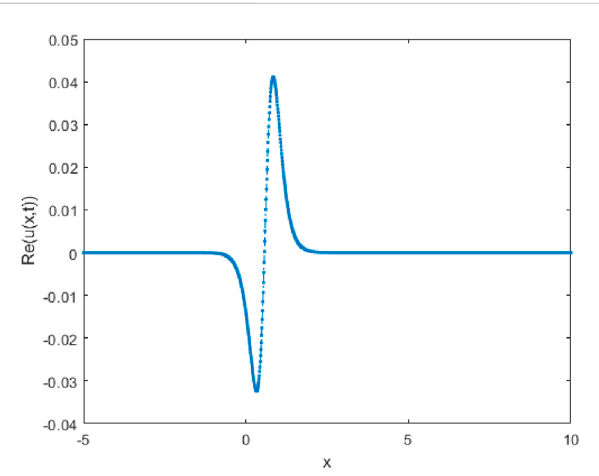
FIGURE 9 2Dplotforsolution(3.22)with k =0.6, α =0.3, δ =0.5, c =2.8,and ρ =